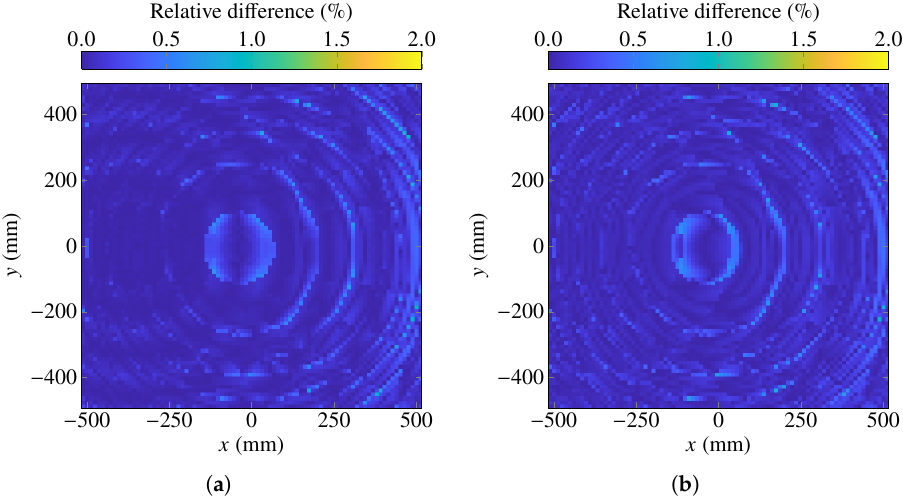
Figure 6. For the reflectarray layout design, relative error of the dipole length T x for each reflectarray element with regard to the design carried out with MoM-LP when employing the ( a ) database and ( b )